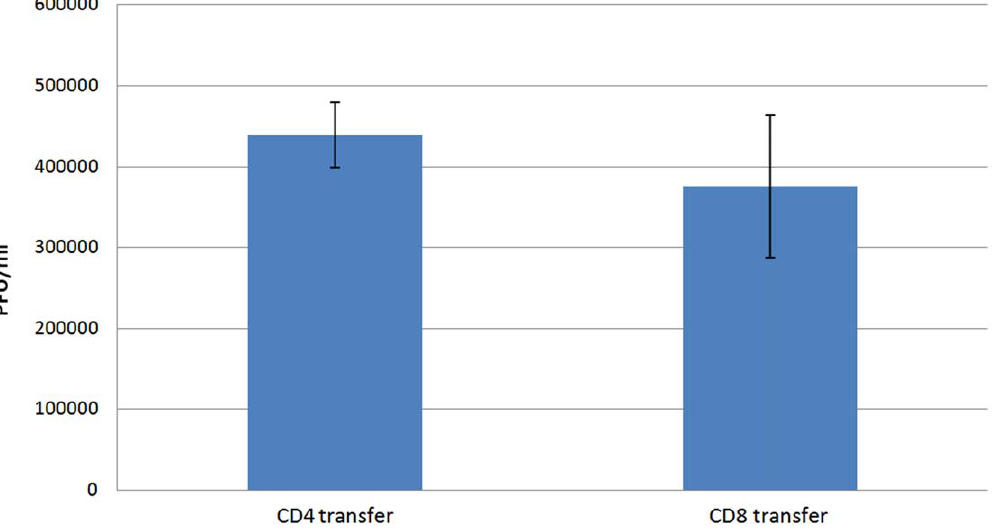
Figure 4. Differences in viral load. We measured TMEV viral load on day 7 following TMEV infection of RAG-1 deficient mice that underwent adoptive transfer of CD4 or CD8 T-cells, respectively. Overall, the viral loads aren’t different (p=0.62) between the two groups, demonstrating that the observed T1BH formation isn’t directly related to viral load.